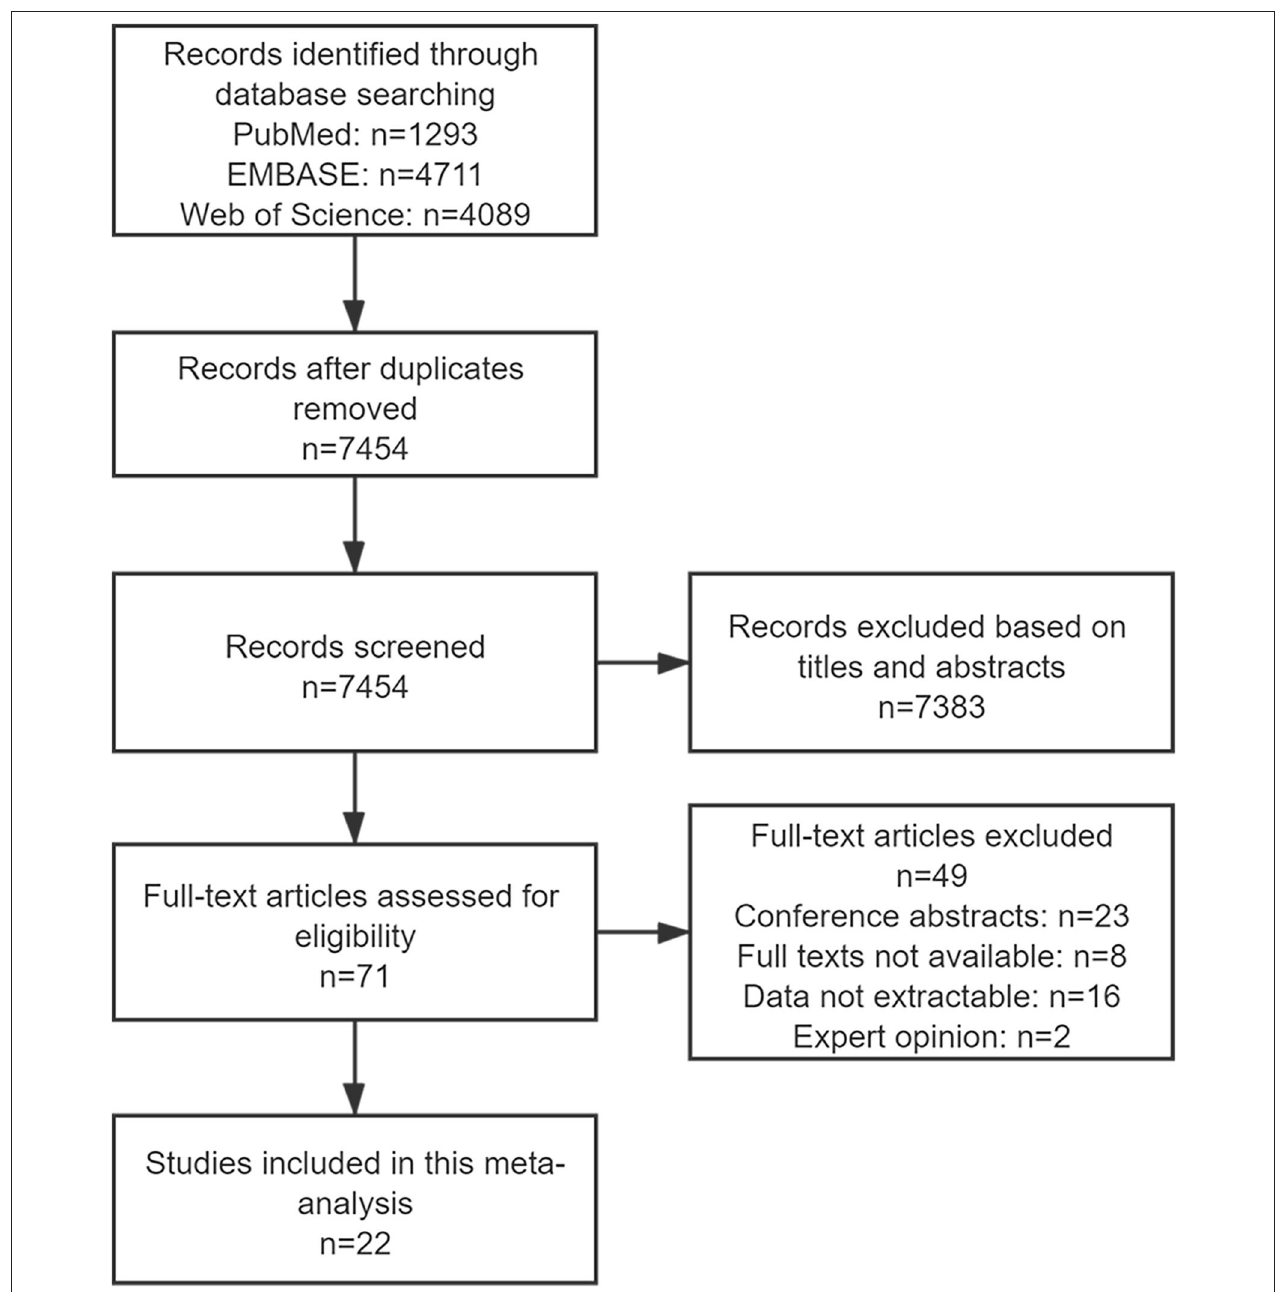
FIGURE 1 | Flow diagram for study selection